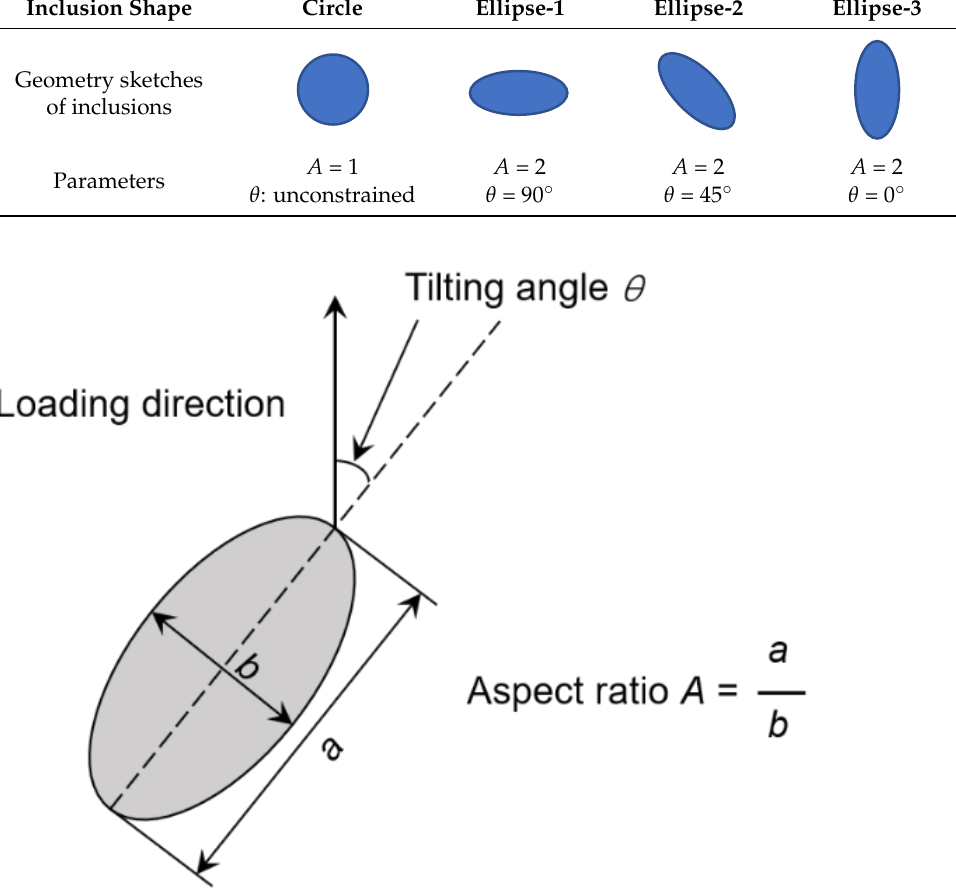
Figure 2. Schematic drawing of the aspect ratio, A , and the tilting angle, θ , of an inclusion.